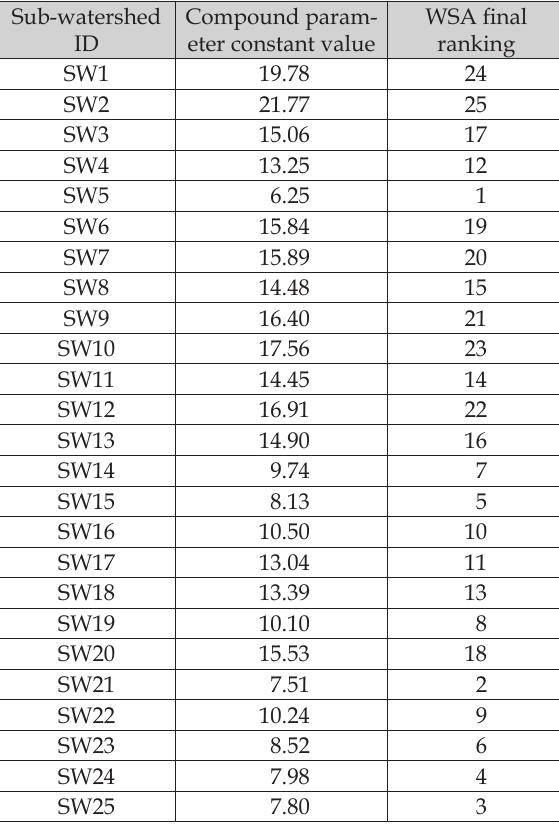
Table 7. Watershed prioritisation and final ranking for erosion susceptibility.